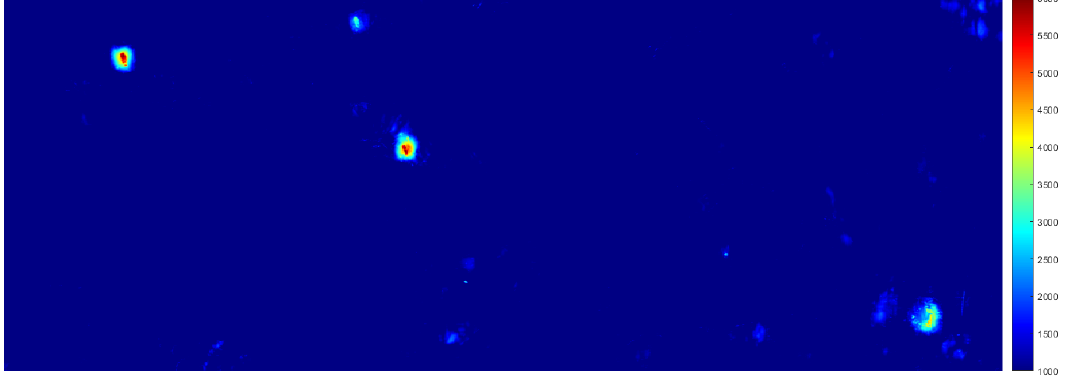
Figure 7. Change map obtained combining the results in Figure 6a,b. The impact of false alarms is mitigated and the four targets stand out